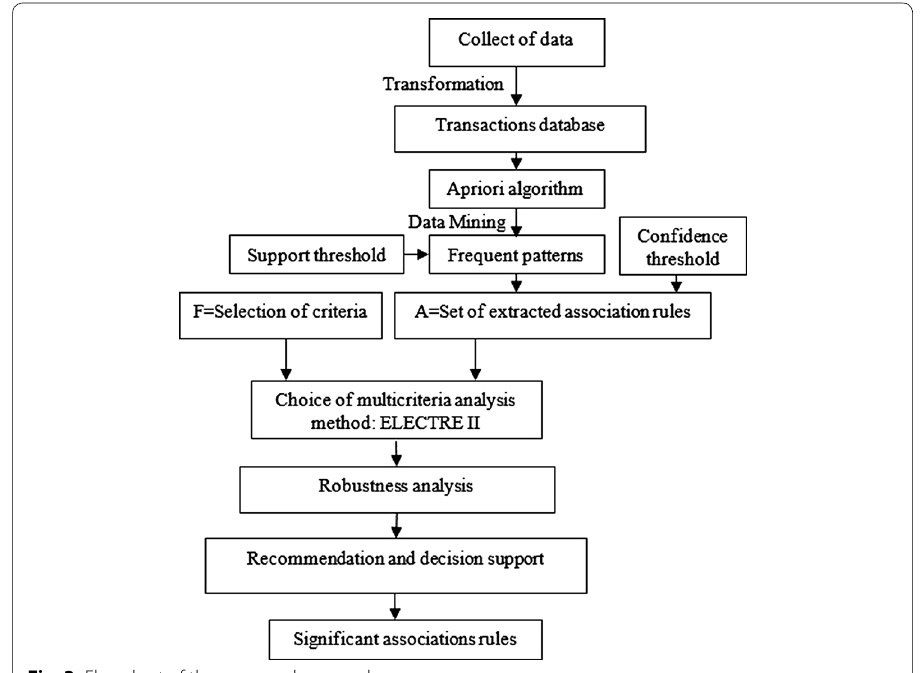
Fig. 3 Flowchart of the proposed